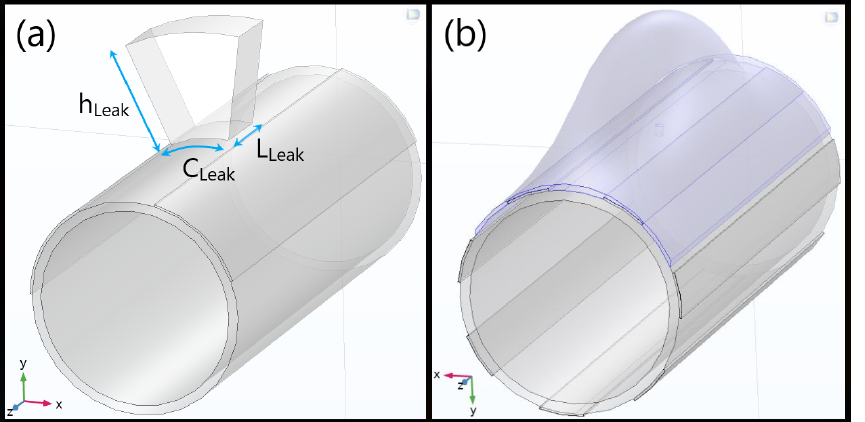
Figure 2. ( a ) Initial model of the leak geometry over a single pair of non-insulated copper electrodes, utilized for refining the gap (G) and width (W); ( b ) Final interdigitated structure adjusted after a few preliminary validation tests and exhibited in advance. An alternative 2 L Gaussian water loss profile is highlighted in blue with an amplitude concentric to a parameterized hole on top, as implemented in the real prototype and better shown in Figure 3a. This model includes both the 50 μ m Kapton ® tape and the ionic double layer enfolding the electrodes.